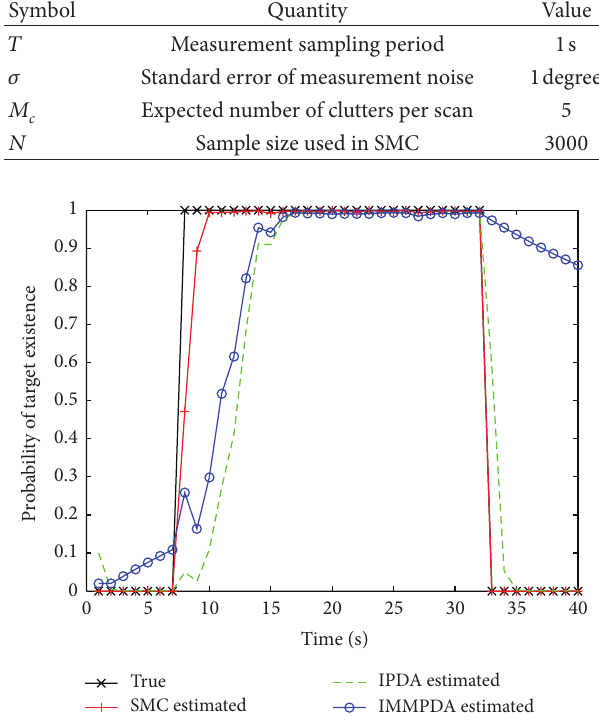
Figure3: Thetrueandtheestimated probabilitiesoftarget existence versus time